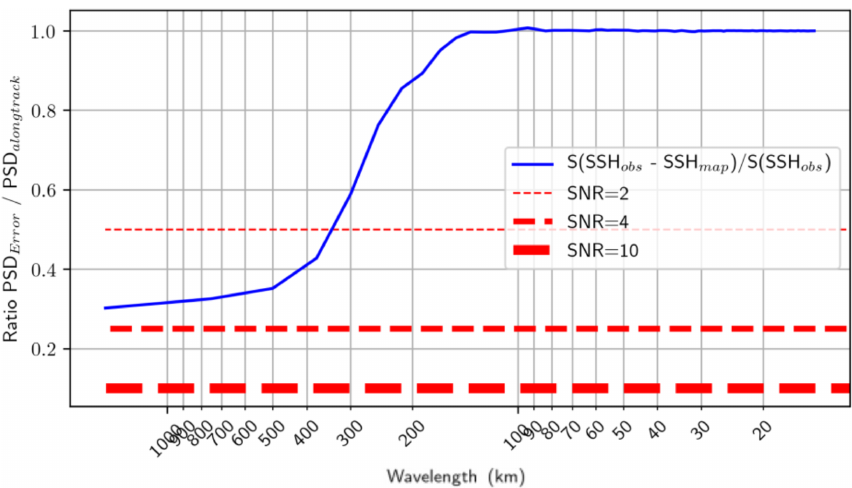
Figure B2. Ratio of NSR at longitude 346 ◦ E and latitude 16 ◦ S. We illustrate that the ratio at this location is always above > 0 . 3 and so the resolution cannot be computed for SNR criterion > 4 (i.e., NSR < 0.25).